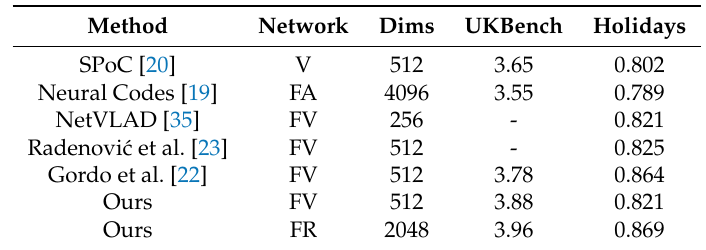
Table 5. Performance comparison with state-of-the-art CNN-based image retrieval methods. The involved network models are marked with “A”, “V”, and “R” for AlexNet, VGGNet-16, and ResNet-50, respectively. Methods adopting a fine-tuned model are marked with “F”; otherwise, off-the-shelf models are implied. Retrieval accuracy is measured by the N-S Score for the UKBench dataset and mAP for the Holidays dataset. “Dims” denotes the dimensionality of image